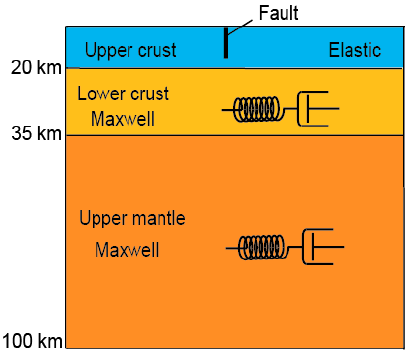
Figure 5. Sketch map shows the viscoelastic model used for post-seismic viscoelastic relaxation effect (PVRE) estimation.